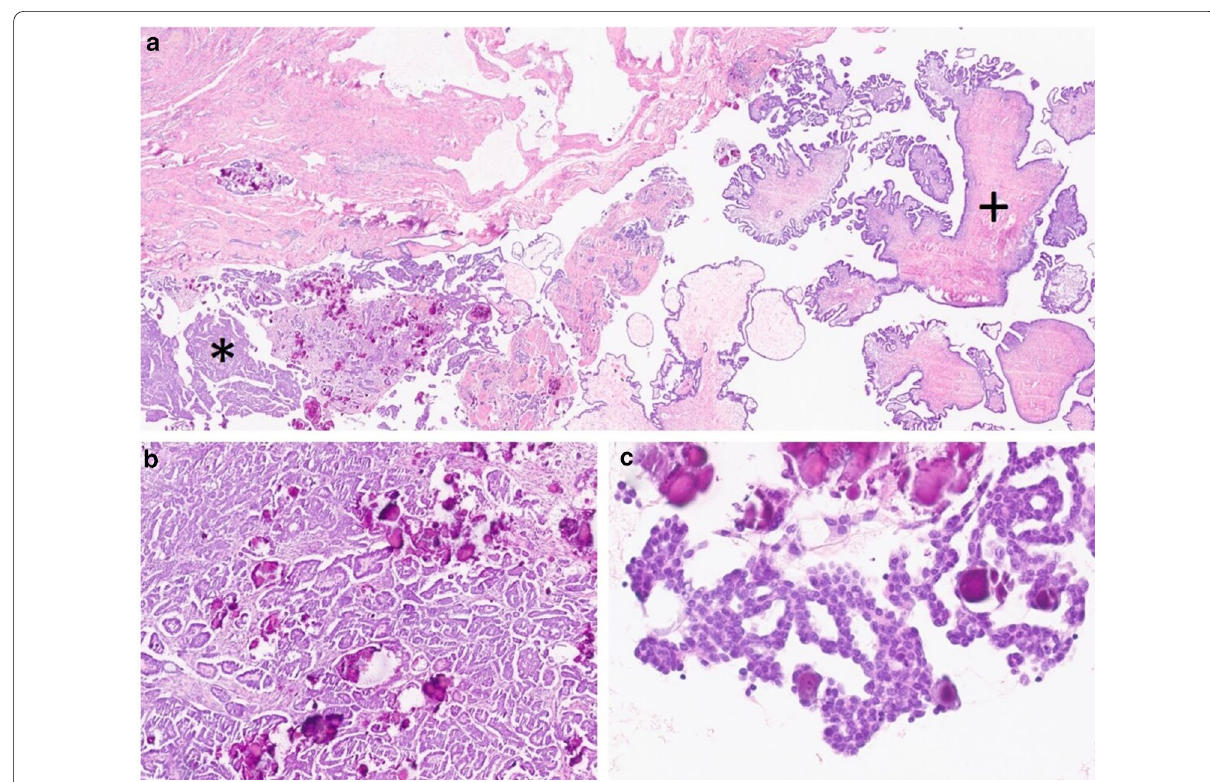
Fig. 2 Microscopic examination of an LGSC associated with SBT. LGSC is present in the left inferior corner of the image (*) and an associated component of SBT is seen in the right side ( ), H&E, 10 ( a ). LGSC is composed of small nest, glands and papillae, immersed in a fibrous stroma, + × with abundant psammoma bodies, H&E, 100 ( b ). In LGSC, papillae are covered with cells with bland appearance, uniform nuclei without × significant atypia and no mitoses are seen; psammoma bodies are present; H&E, 200 ( c ×